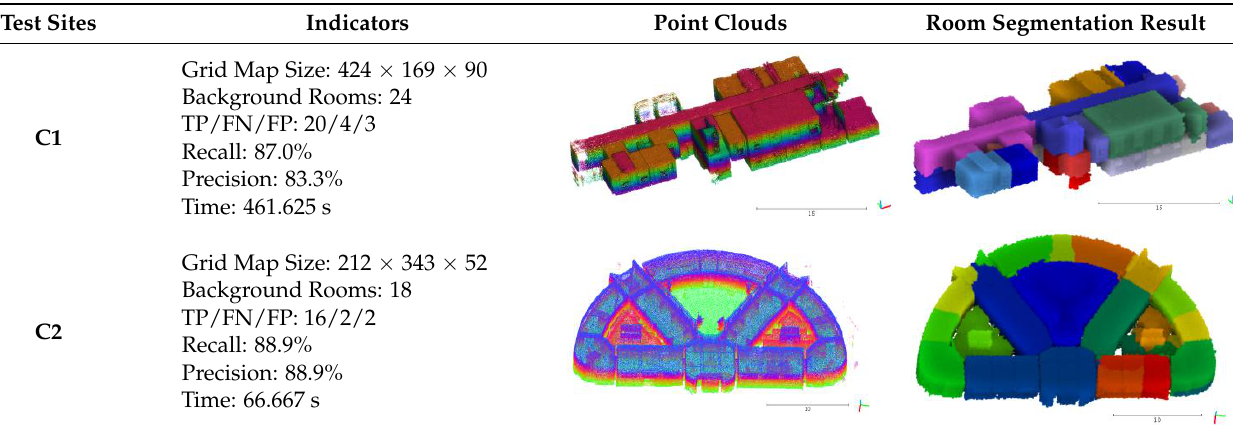
Table 4. Indicators and room segmentation results of the proposed method for real-world datasets. Test Sites